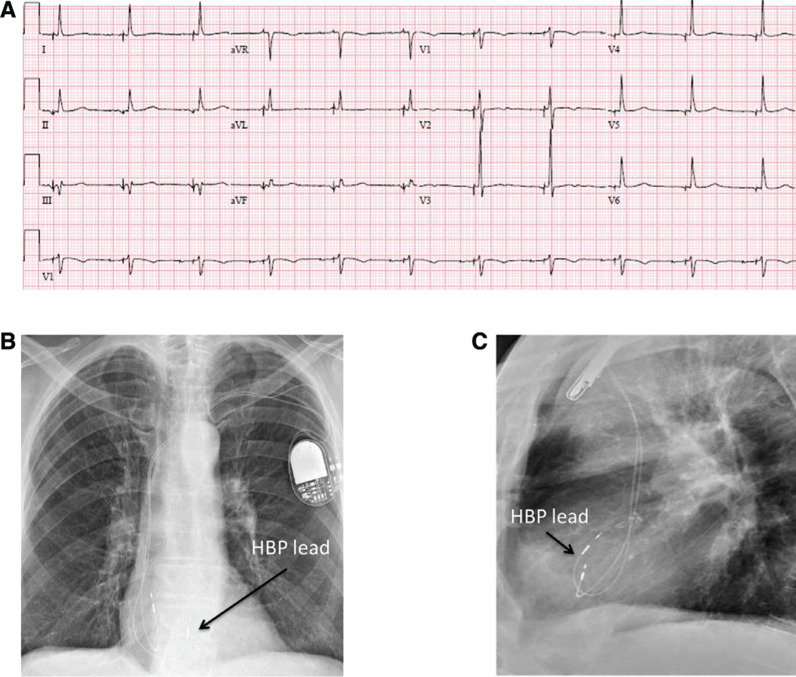
A: A 12-lead ECG with atrial and selective His-bundle pacing; QRSd: 90 ms. Note the normal-appearing QRS complexes with no T-wave changes. B: A posteroanterior chest X-ray of the right atrial and His-bundle pacing leads. C: A lateral chest X-ray of the right atrial and His-bundle pacing leads. HBP: His-bundle pacing.